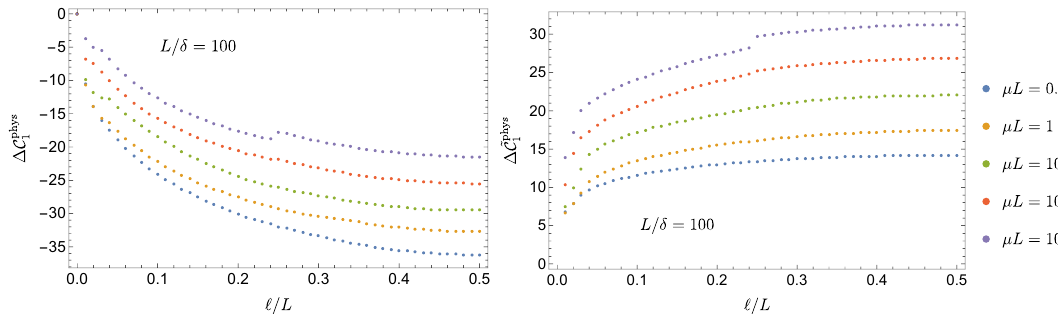
Figure 21 . The two de(cid:12)nitions of mutual complexity in the physical basis (cid:1) C phys function of the subregion size for various reference frequencies. The cuto(cid:11) was set to L=(cid:14) = N = 100 and the mass to mL = 0 : 01. Note the small discontinuity at ‘=L = 1 = 4 for larger values of (cid:22)(cid:14) . The discontinuity is very small for (cid:22)(cid:14) = 1 and becomes quite noticeable for (cid:22)(cid:14) = 10 where reference frequency becomes larger than cuto(cid:11). We associate this e(cid:11)ect with the discrete nature of our regularization. In the continuum limit, for reference frequencies around or below the cuto(cid:11), we expect this discontinuity to disappear as we take the limit (cid:14) !